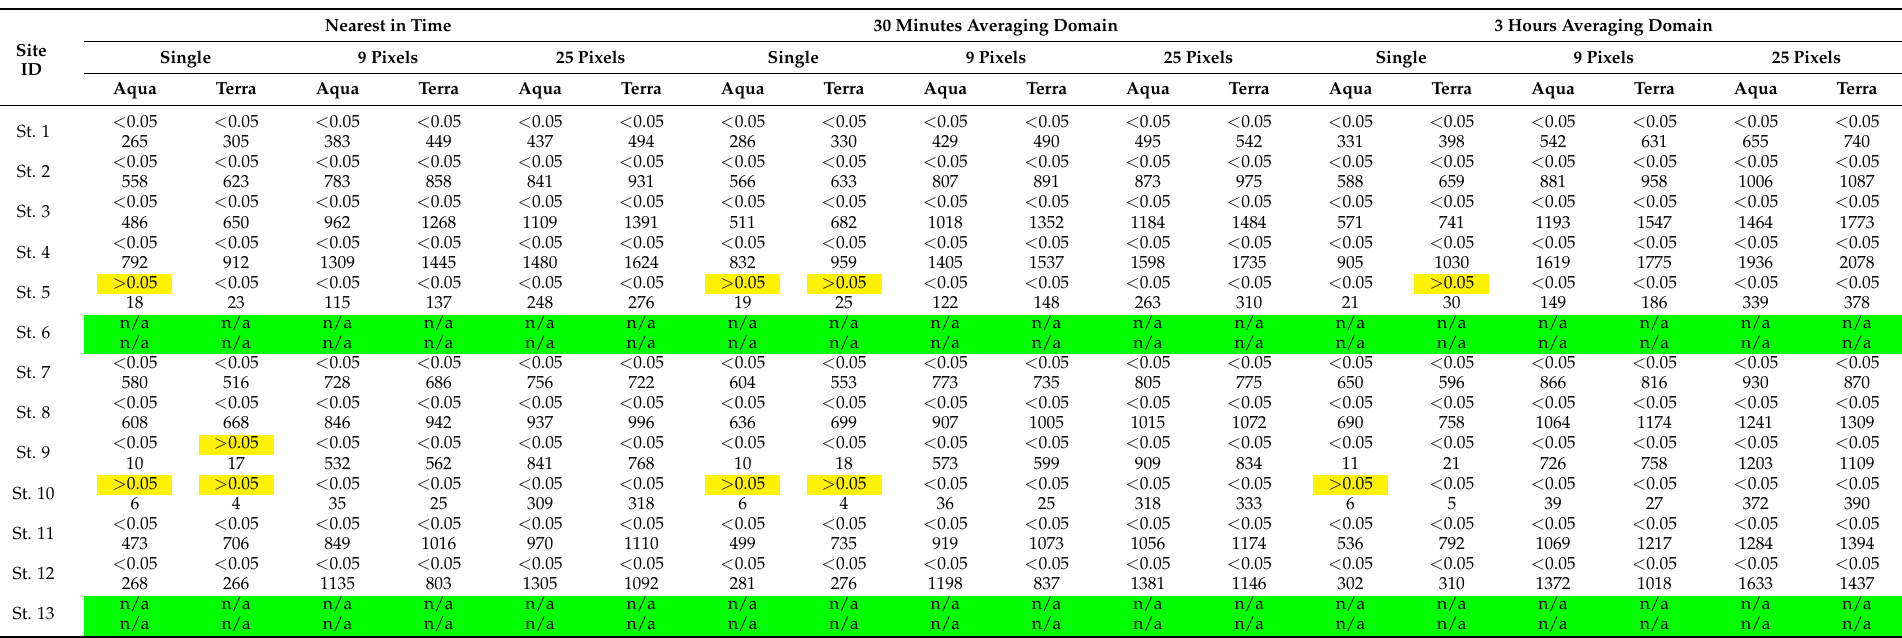
Table A2. p -value and number of matched samples between MODIS DT (land and ocean) AOD and AERONET AOD of 23 sites across western United States at different combinations of temporal and spatial averaging domains. The yellow shaded cells represent not significant correlation and green shaded cells represent no